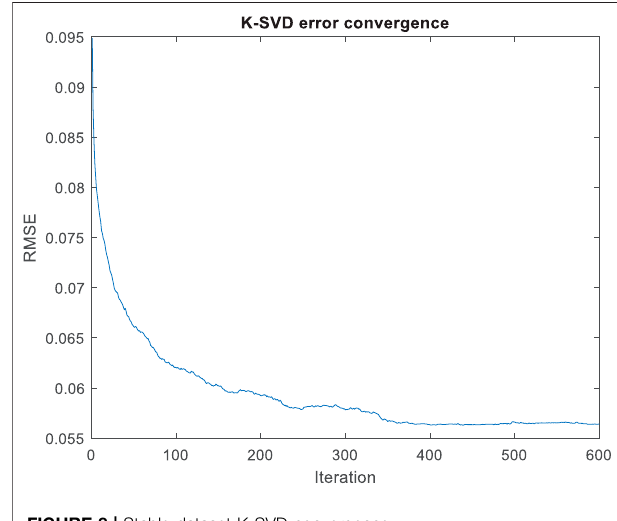
FIGURE 8 | Stable dataset K-SVD convergence.